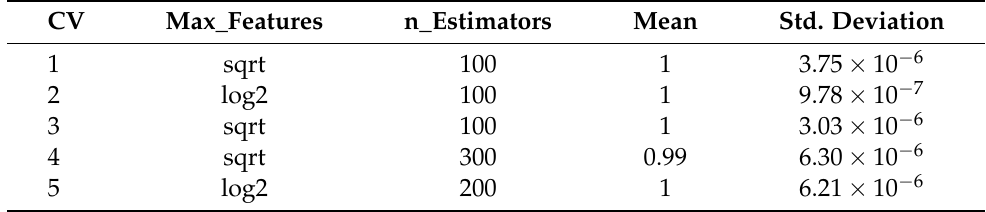
Table 3. Best Random Forest model by